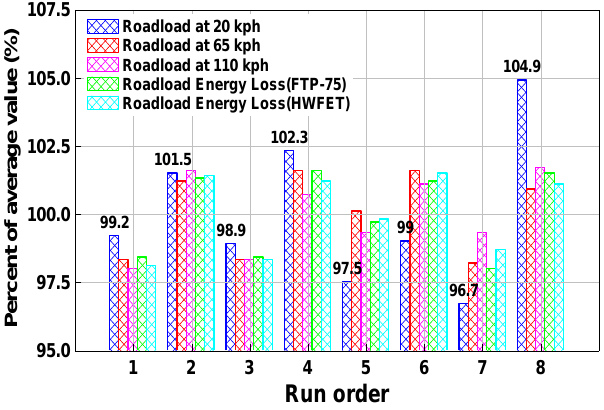
Figure 9. Relative scale compared with the average value in each road load condition.